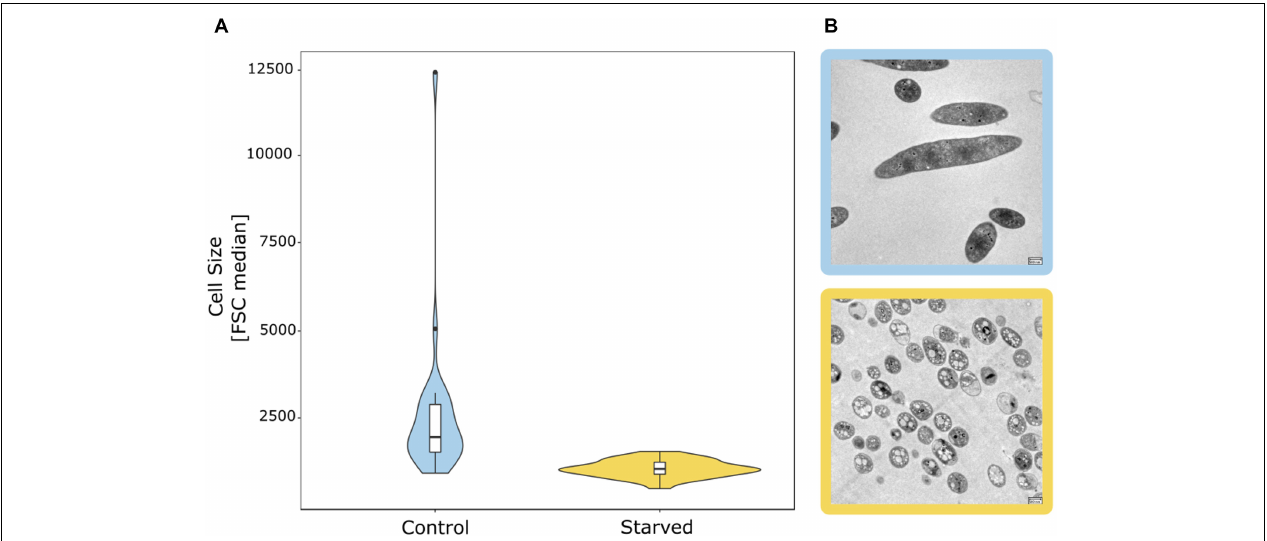
FIGURE 2 | Starvation-induced reduction in the cell size of bacterial groundwater isolates. (A) Distribution of the median FSC signal of 26 isolates as a proxy for cell size in cultures grown in full medium with 880 mg/L C org (control) vs. starved cultures with 0.088 mg/L C org . (B) Change of cell size and morphology based on TEM pictures of groundwater isolate hainich_200 (affiliated with Flavobacterium sp.) from full medium culture (blue frame) to starved culture (yellow frame). Scale bar: 500 nm.